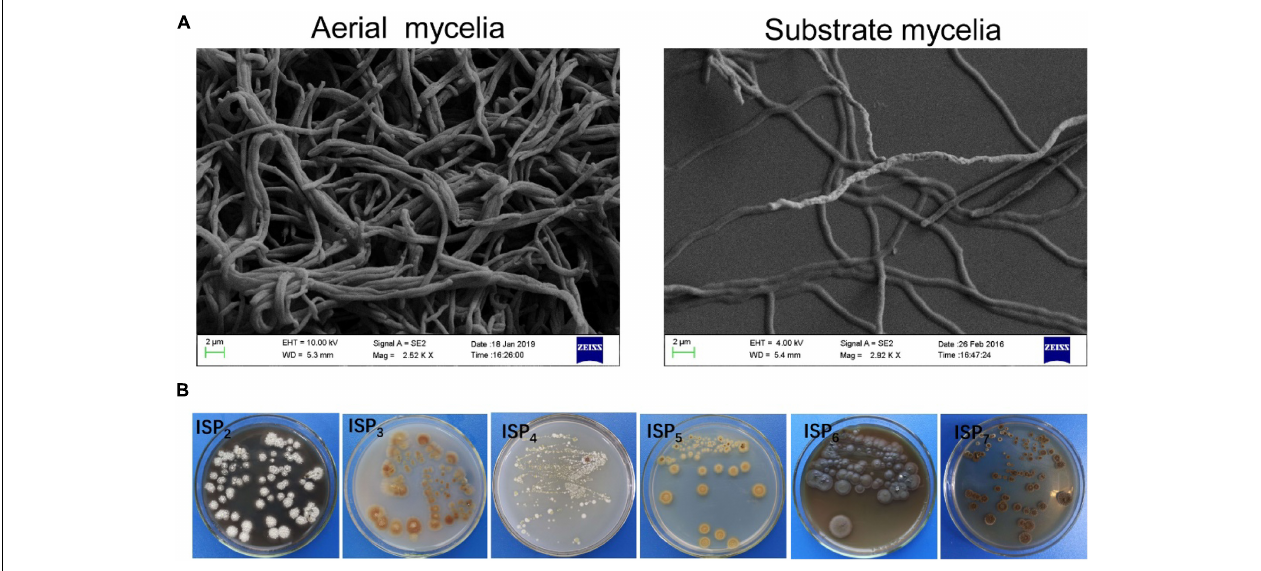
FIGURE 3 | Mycelial and morphological characteristics of SCA2-4 T . (A) Aerial and substrate mycelia were detected on the YE agar medium at 28 ◦ C for 21 days using the scanning electron microscope. (B) Cultural characteristics of strain 2-4 T on six ISP media.